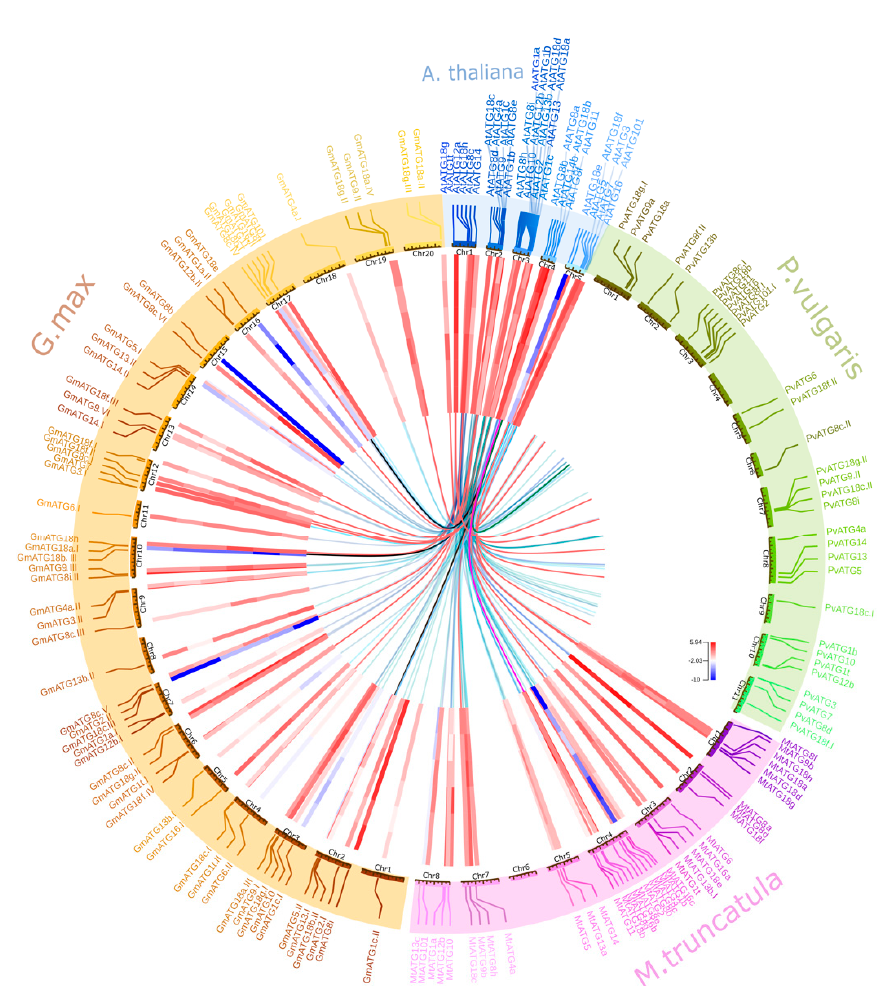
Figure 2. The chromosomal localization, synteny relationship and gene expression of autophagy genes were integrated into the Circos plot designed using OmicCircos. The outermost circle shows the A. thaliana (blue), P. vulgaris (green) , M. truncatula (pink) and G. max (brown) chromosomes. The inner circle is a heatmap that shows the log 2 RPKM values of gene expression in leaves and roots under ammonia, nitrate and urea treatments. The innermost line is the synteny of autophagy genes, but the yellow, purple and red lines represent ATG18b subfamilies I, II and III, respectively. The Ka/Ks ratio among most of the ATG sequences was lower than 1 (average 0.17), which indicates purifying selection; in contrast, the sequences of ATG8 (1.24) and two sequences (GmATG18e and GmATG18b. I) of ATG18 (1.09 and 1.04) in G. max had values higher than 1, which indicated accelerated evolution and positive selection (Figure 3). The Ka/Ks ratios suggest the conservation of ATG homologs in terms of both sequence and biological function.